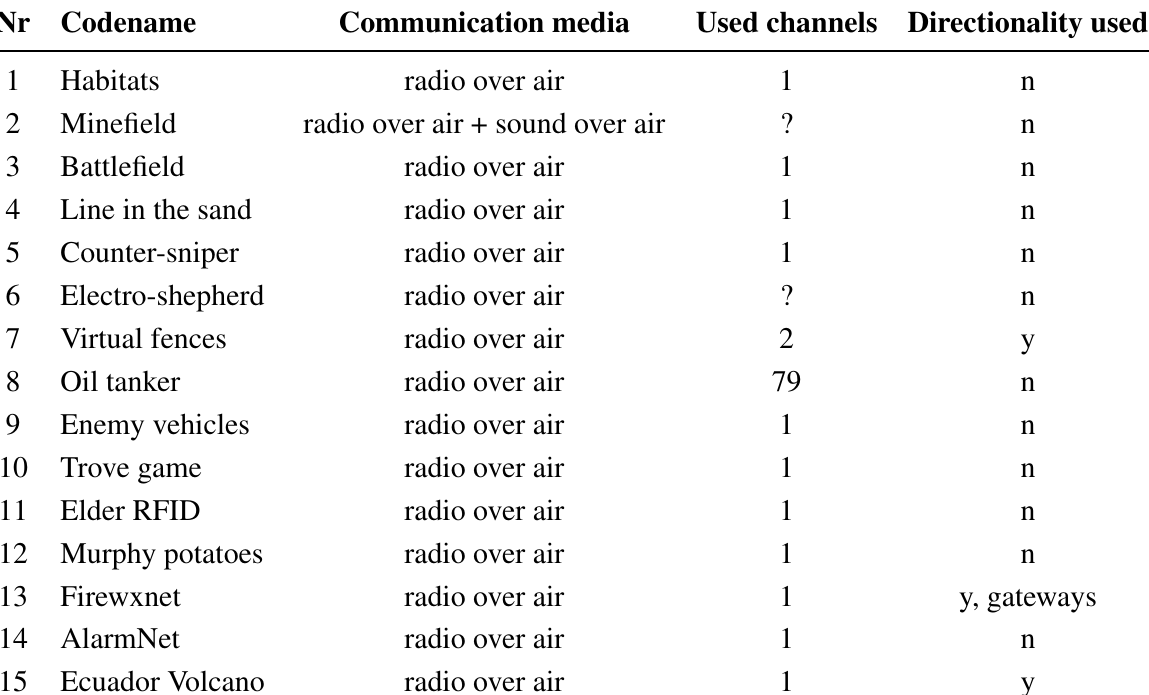
Table 9. Deployments: communication